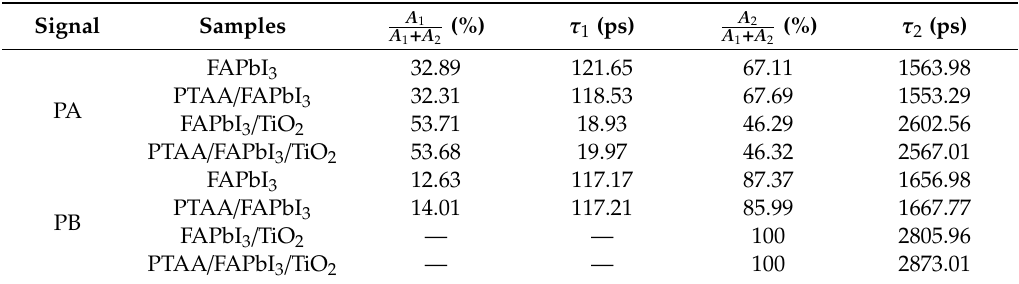
Figure 3. Normalized kinetic traces of ( a ) PA probed at 570 nm and ( b ) PB probed at 770 nm for the films in vacuum after excitation at 400 nm with pump fluence of ≈ 3.5 µ J / cm 2 . The solid curves represent the fitting results. Table 1. Parameters used to fit the temporal evolution of the PA and PB decay signals of the samples excited at 400 nm with pump fluence of ≈ 3.5 µ J / cm 2